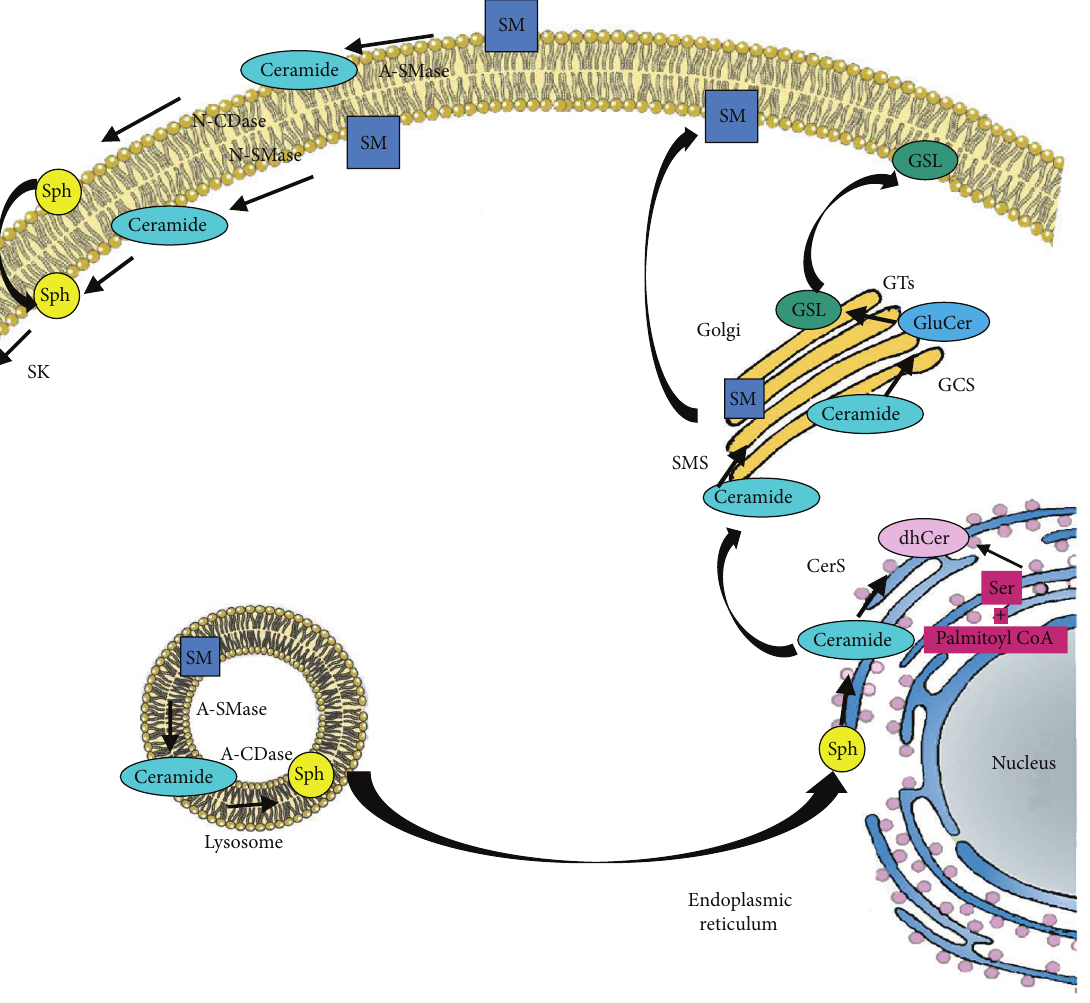
Figure 1: Schematic representation of main sphingolipid metabolic pathway. SM: sphingomyelin; Cer: ceramide; A-SMase: acid sphingomyelinase; N-SMase: neutral sphingomyelinase; A-CDase: acid ceramidase; N-CDase: neutral ceramidase; SMS: sphingomyelin synthase; Sph: sphingosine; S1P: sphingosine-1-phosphate; SK: sphingosine kinase; dhCer: dihydroceramide; CerS: ceramide synthase; GluCer: glucosylceramide; GCS: glucosylceramide synthase; GT: glycosyltransferase; GSL: ganglioside; Ser: